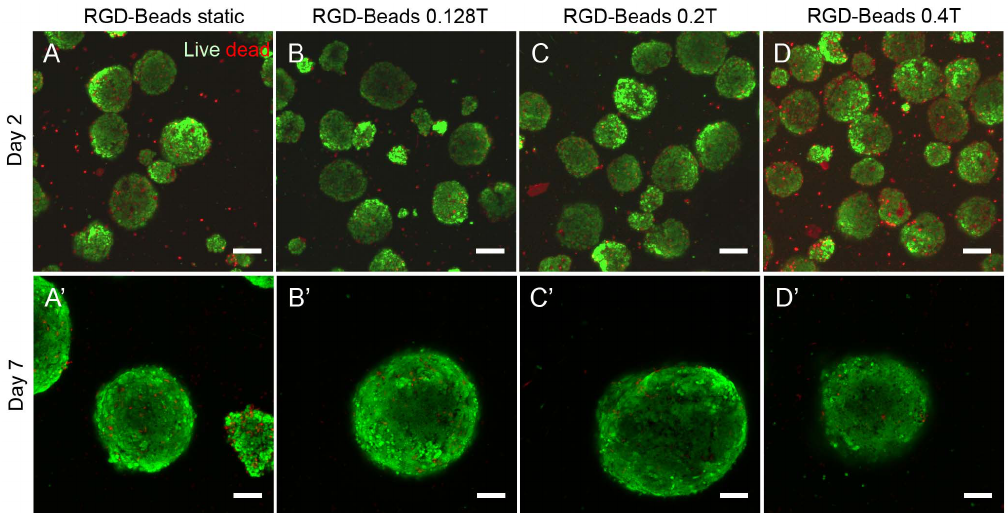
Fig. 3. Live/dead analysis of EBs containing RGD-Beads following magnetization. Live/dead was analyzed by confocal microscopy 24 hours after magnetic attraction (A–D) or 6 days after magnetic attraction (A 9 –D 9 ). Scale bar: 100 m